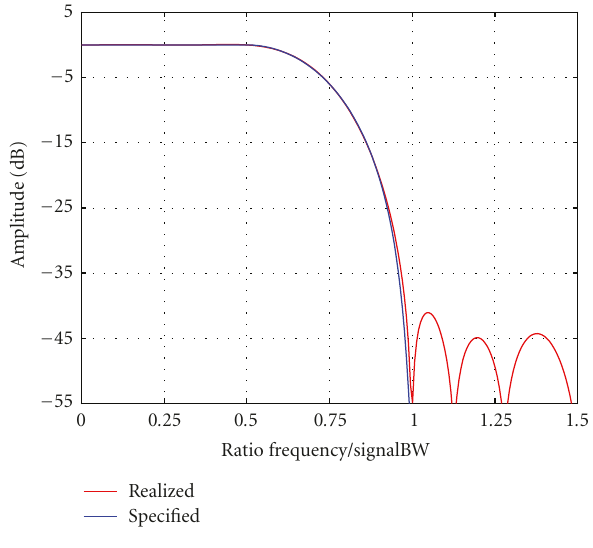
Figure 7: Realized filter transfer function.